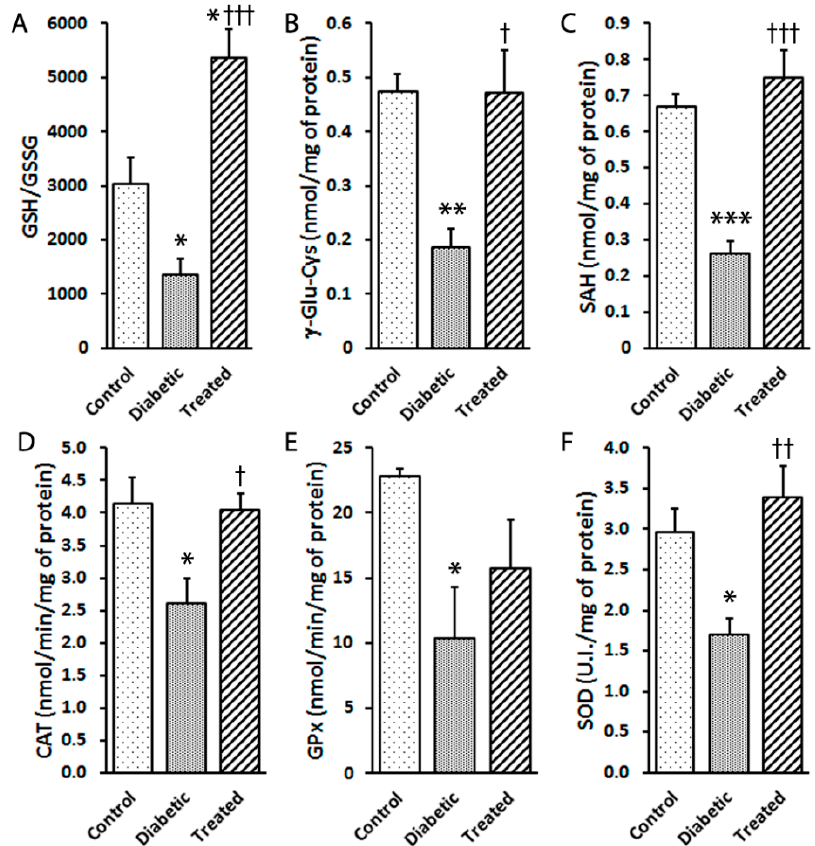
Figure 4. Effect of pterostilbene on antioxidant machinery activation in diabetic rabbits. Type 1 diabetes mellitus and Pter treatment were performed as described in Figure 2. The analyses of retinal ( A ) GSH/GSSG, ( B ) γ -Glu-Cys and ( C ) SHA were performed by UPLC-MS/MS. The enzymatic activities of ( D ) catalase (CAT), ( E ) glutathione peroxidase (GPx) and ( F ) superoxide dismutase (SOD) were determined by spectrophotometry. Data are presented as mean ± SEM (at least n = 4 in each group). Statistical analyses were performed by a one-way ANOVA followed by Tukey’s test. * p < 0.05; ** p < 0.01; *** p < 0.001 versus the control group. † p < 0.05; †† p < 0.01; ††† p < 0.001 versus the diabetic group.